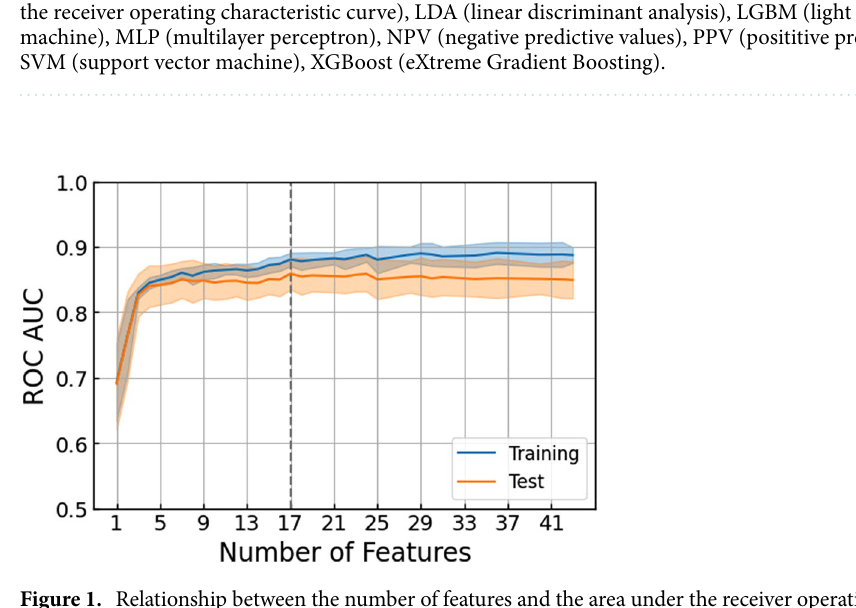
Figure 1. Relationship between the number of features and the area under the receiver operating characteristic curve for the prediction algorithm. The line plot depicts sequential changes in the AUC with the number of features for the prediction algorithm in ( a ) the training score (blue) and ( b ) the test score (yellow). The dotted vertical line indicates the highest predictive value in the test score. (n = 17, AUC of the training score = 0.881, AUC of the test score = 0.859). The error bars indicate 95% confidence intervals. AUC (area under the receiver operating characteristic